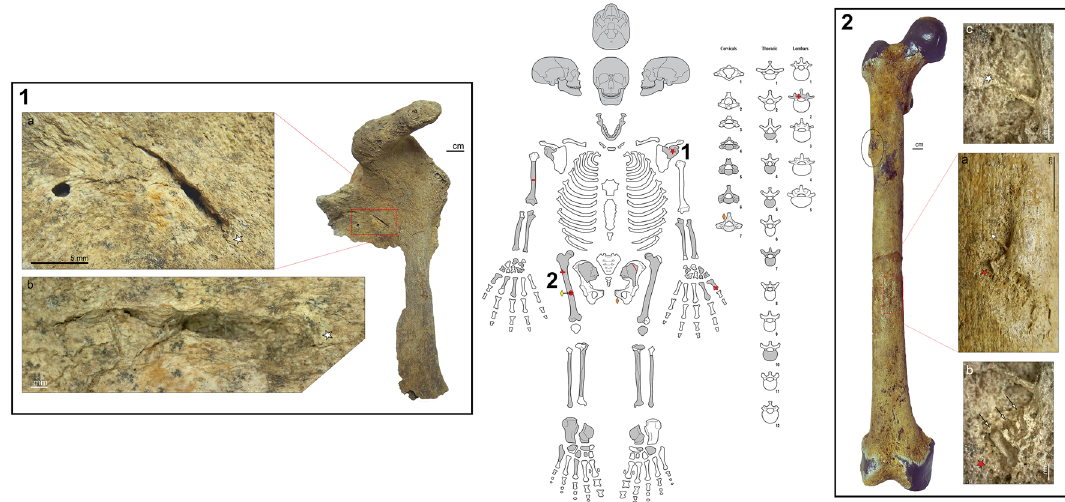
Figure 3. Location and images of the observed osseous lesions on JS 31. Center: schematic scheme of JS 31 ′ s skeletal preservation. Grey parts represent preserved bones, striped areas are missing bone or areas, full star = unhealed puncture, dash = drags traces of projectile impacts, line = cutmark, plus sign = healed lesions, time sign = healed fracture, full circle = healed puncture, yellow diamond = embedded artefact in a puncture, orange diamond = embedded artefact in lost bone. Box n°1: Projectile impact puncture on the left scapula of JS 31. a = red rectangle close up on the subscapular fossa showing the puncture associated with flaking and faulting. b = composite microscopic image of the puncture displaying the crushing of the bone in the lower border of the puncture (magnification ×40). Box n°2: Healed lesions on the right femur of JS 31. Red rectangle = healed projectile lesion, black ellipse = bone callus. a = red rectangle close up of the healed projectile injury with red and white stars as reference points for the magnified area b and c. b = microscopic view of the three embedded lithic chips marked by arrows. c = microscopic view of a bony bridge separating two geometric marks indicating the presence of two lost lithic chips (magnification